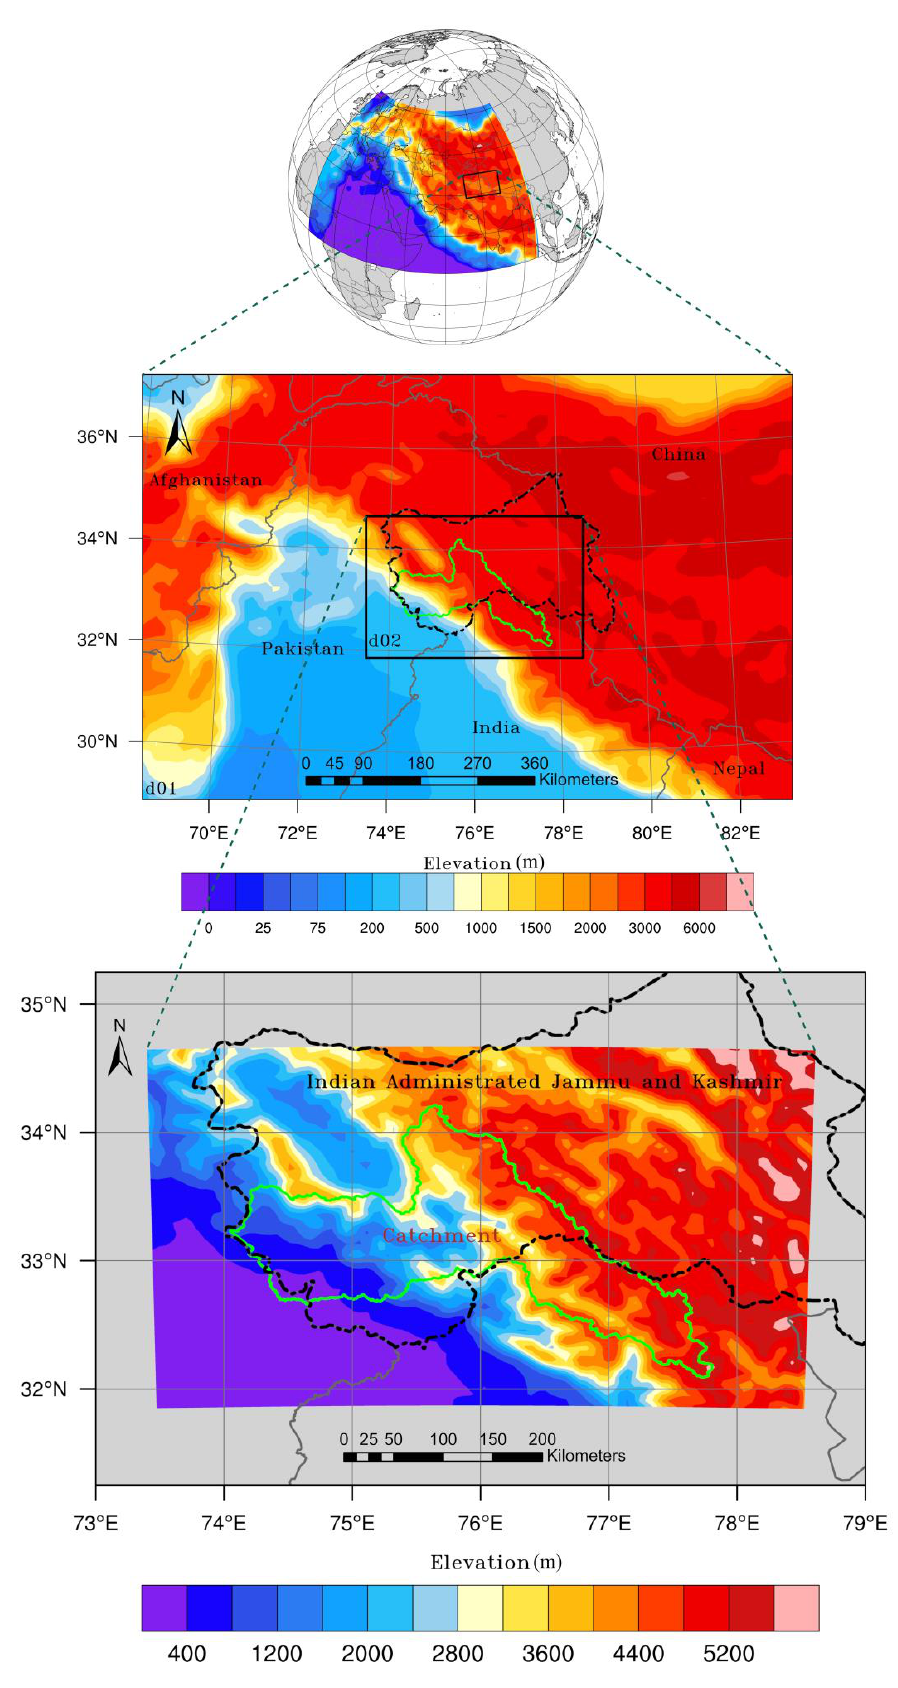
Figure 4. WRF model configuration with representation of domains and